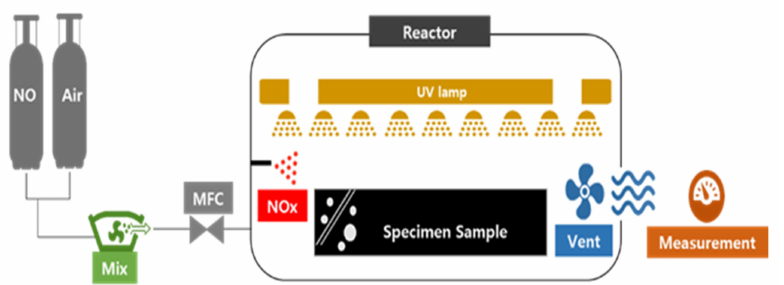
Figure 4. Schematic diagram of the NOx analysis system.